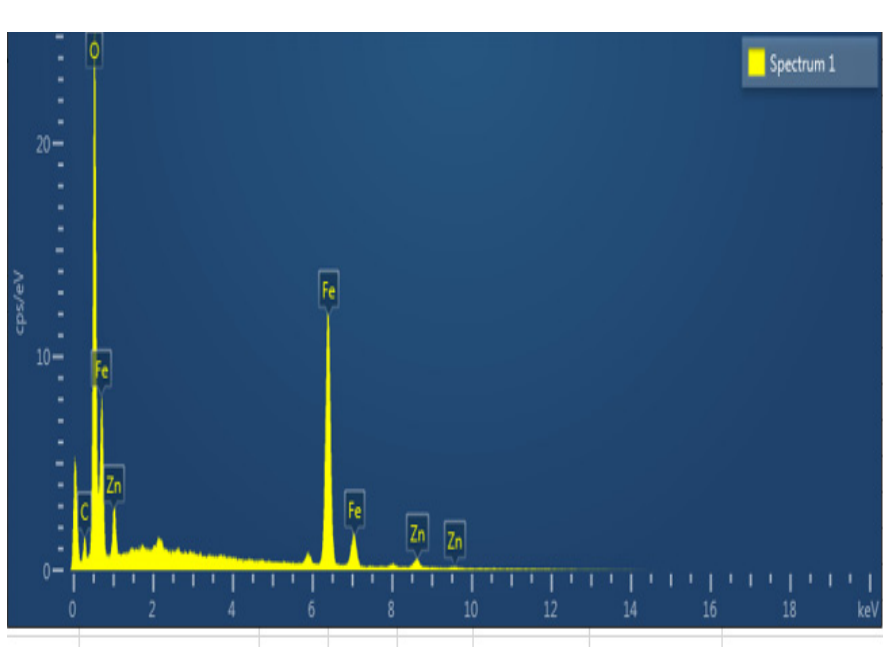
Figure 2. EDX spectrum of Zn/iron oxide NPs.